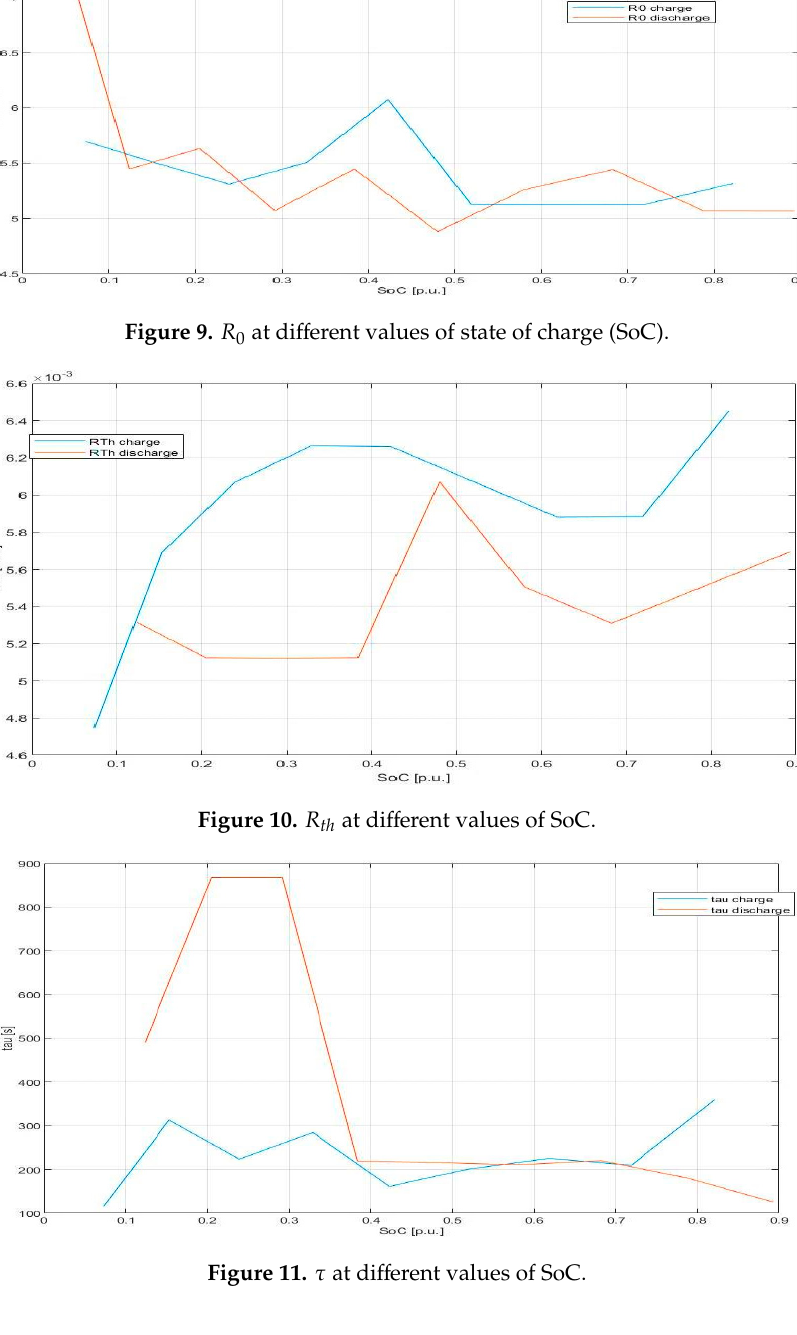
Figure 12. (cid:1829) (cid:3047)(cid:3035) at different values of SoC.